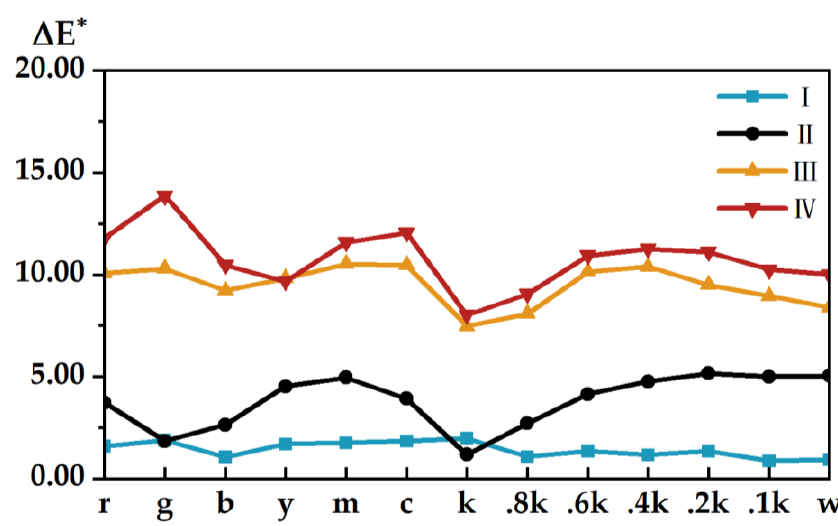
Figure 5. Three-dimensional test plate surface color average chromaticity.